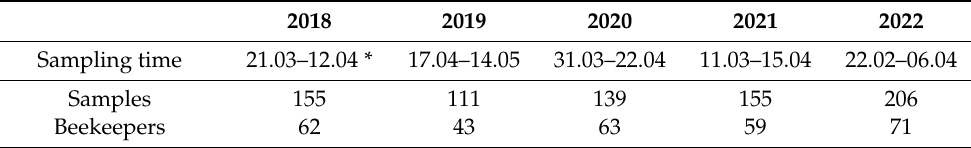
Table 1. Samples from beekeepers in the years